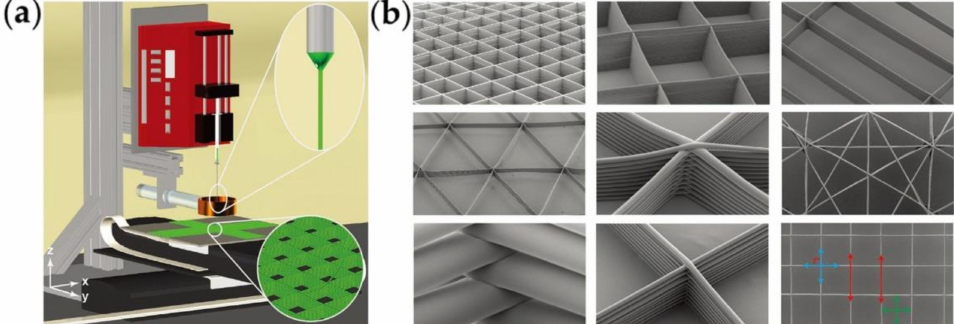
Figure 4. ( a ) The illustration of the 3D jet writing setup; ( b ) the SEM image of the fibrous scaffolds made by 3D jet writing. Reprinted from [41], with permission from Wiley. © 2021 WILEY-VCH Verlag GmbH & Co. KGaA,